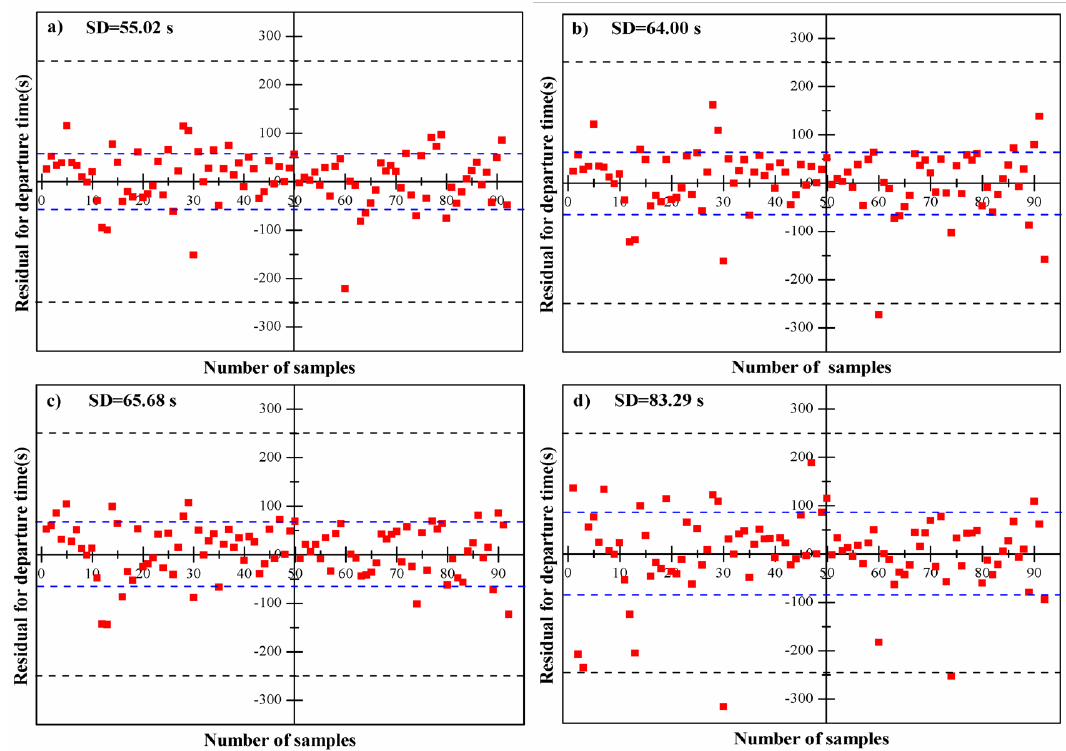
Figure 6. Residual for departure time at different points ( N = 92) under the situation where the ground-truth departure time estimated by thermal footprint model: ( a ) one-third point, ( b ) one-half point, ( c ) two-thirds point, and ( d ) three-fourths point. (A total of 15 points with large deviations (>350 s) were